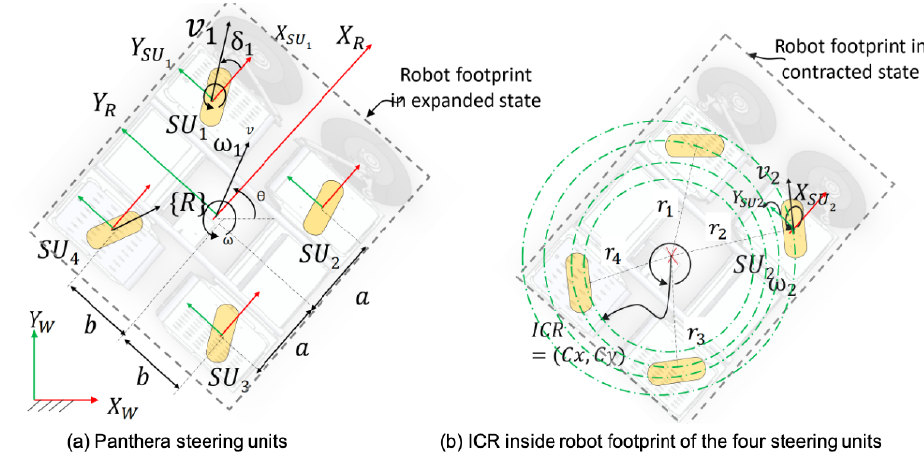
Figure 3. Panthera steering units and